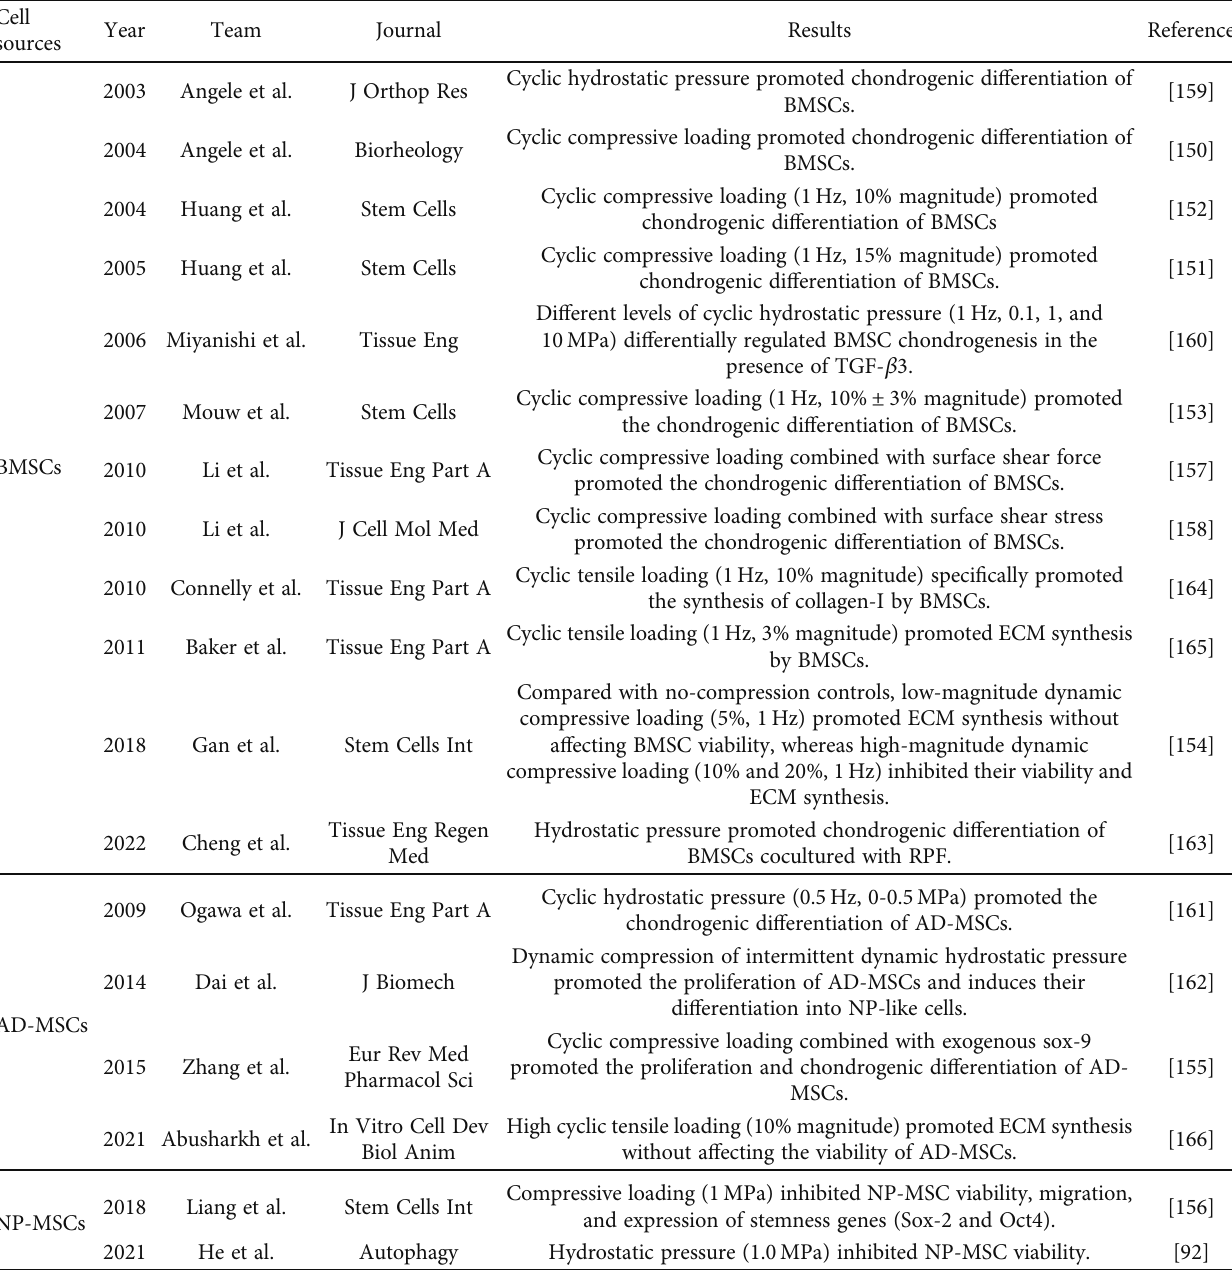
Table 6: E ff ects of mechanical stress on the biological behavior of